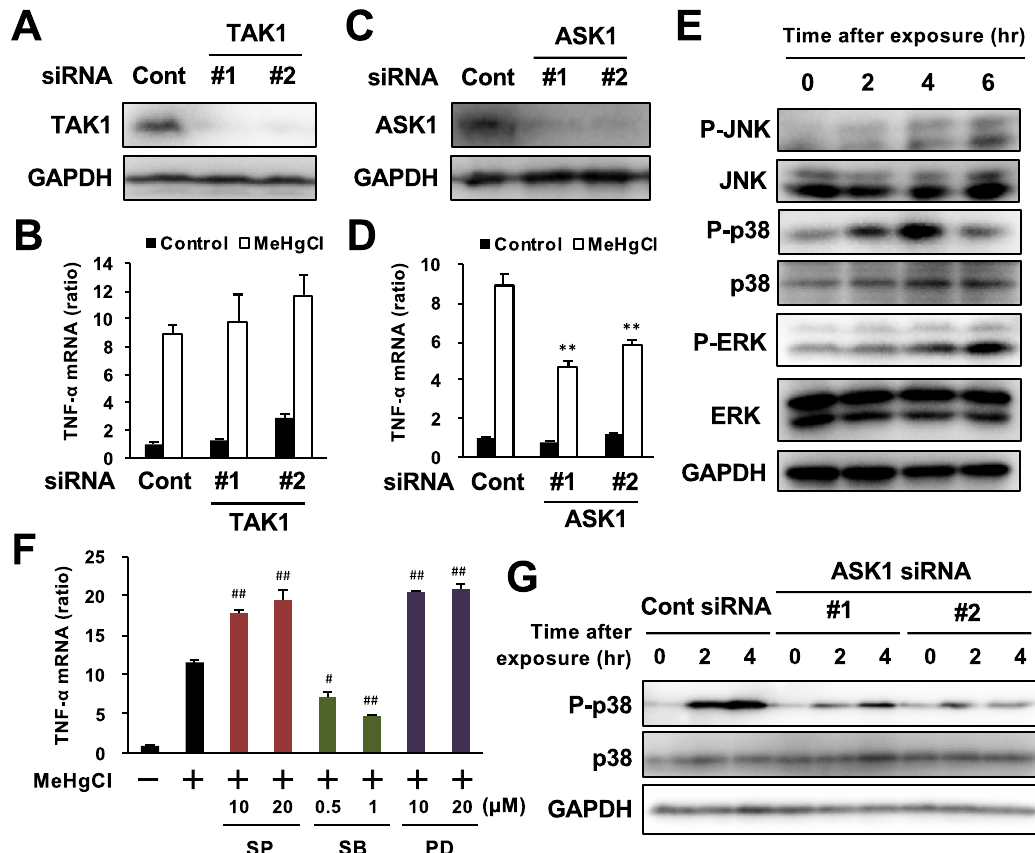
Figure 3. Involvement of MAP kinase pathways in methylmercury-induced TNF-α expression in BV2 cells. BV2 cells were transfected with two different sequences of TAK1 or ASK1 siRNA (#1 or #2) and incubated for 24 h or 48 h (there was no suppression of ASK1 expression at 24 h after siRNA transfection). Protein levels of ( A ) TAK1 or ( C ) ASK1 were determined by Western blotting. ( B,D ) The cells were exposed to MeHgCl (20 µM) for 6 h and mRNA levels of TNF-α were measured by qPCR (n = 3). The data are shown as actin-corrected means ± standard deviations. The Y-axis indicates the ratio with the control as 1. ( E ) BV2 cells were exposed to 20 µM of MeHgCl for the indicated time course and phosphorylation of MAP kinases were determined by Western blotting. ( F ) The cells were pretreated with indicated concentrations of SP600125 (SP; JNK inhibitor), SB203580 (SB; p38 inhibitor), or PD98059 (PD; MEK/ERK inhibitor) for 30 min, then 20 µM of MeHgCl were added to the medium and incubated for a further 6 h. mRNA levels of TNF-α were measured by qPCR (n = 3). The data are shown as actin-corrected means ± standard deviations. The Y-axis indicates the ratio with the control as 1. ( G ) The cells were transfected with two different sequences of ASK1 siRNA for 48 h. The cells were exposed to 20 µM of MeHgCl for the indicated time course and phosphorylation of p38 was determined by Western blotting. * P < 0.05 vs control, ** P < 0.01 vs control. # < 0.05 vs MeHgCl(+), ## < 0.01 vs